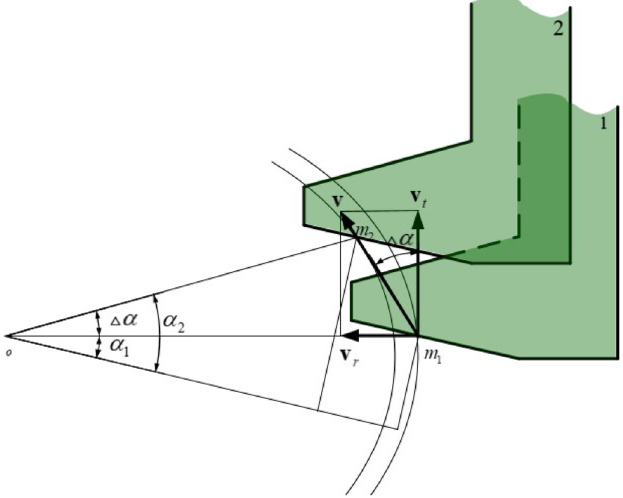
Fig. 4. In fl uence of helical motion on